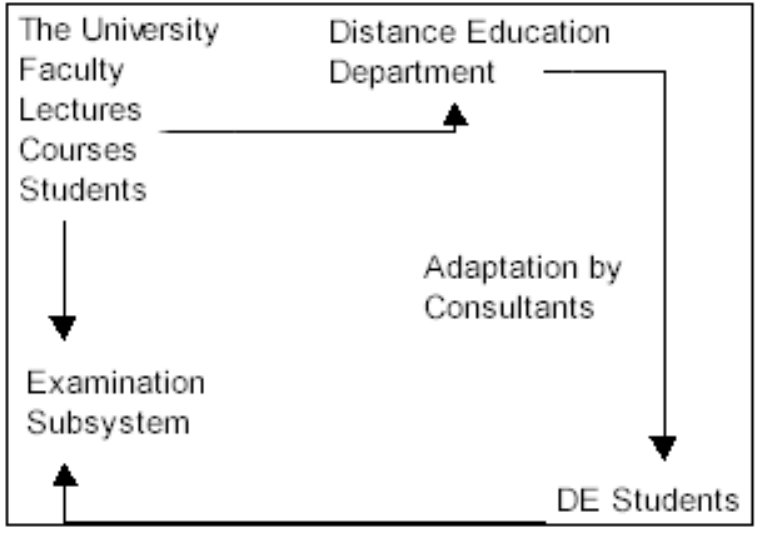
Fig.1: Distance education courses from a university